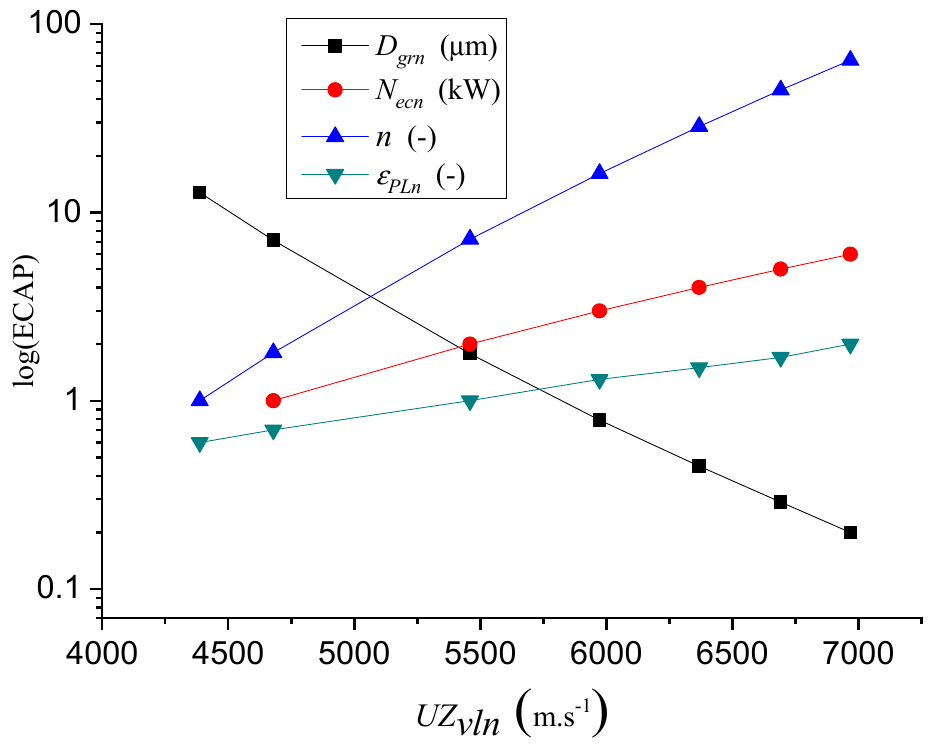
Figure 11. Correlation relations log f(ECAP) = f( UZ vln ).